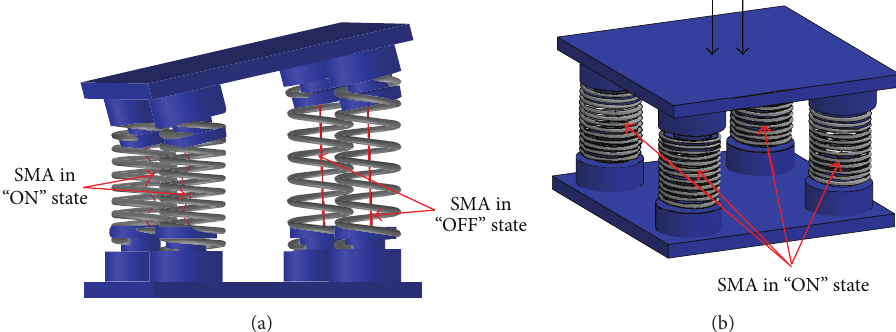
Figure 4: The mobility of developing Stewart platform; (a) tilting effect of Stewart platform; (b) linear 𝑧 -axis